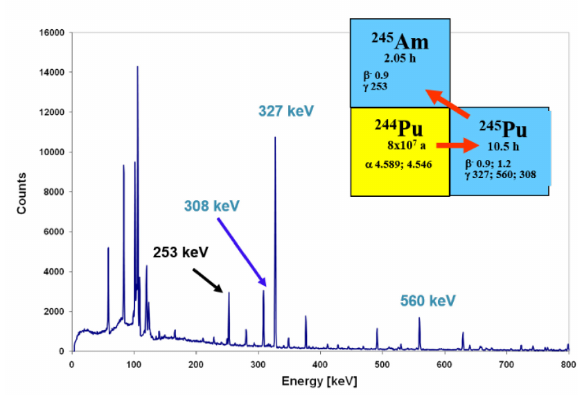
Fig. 1. γ -ray spectrum of a 244 Pu solution irradiated at the research reactor TRIGA Mainz